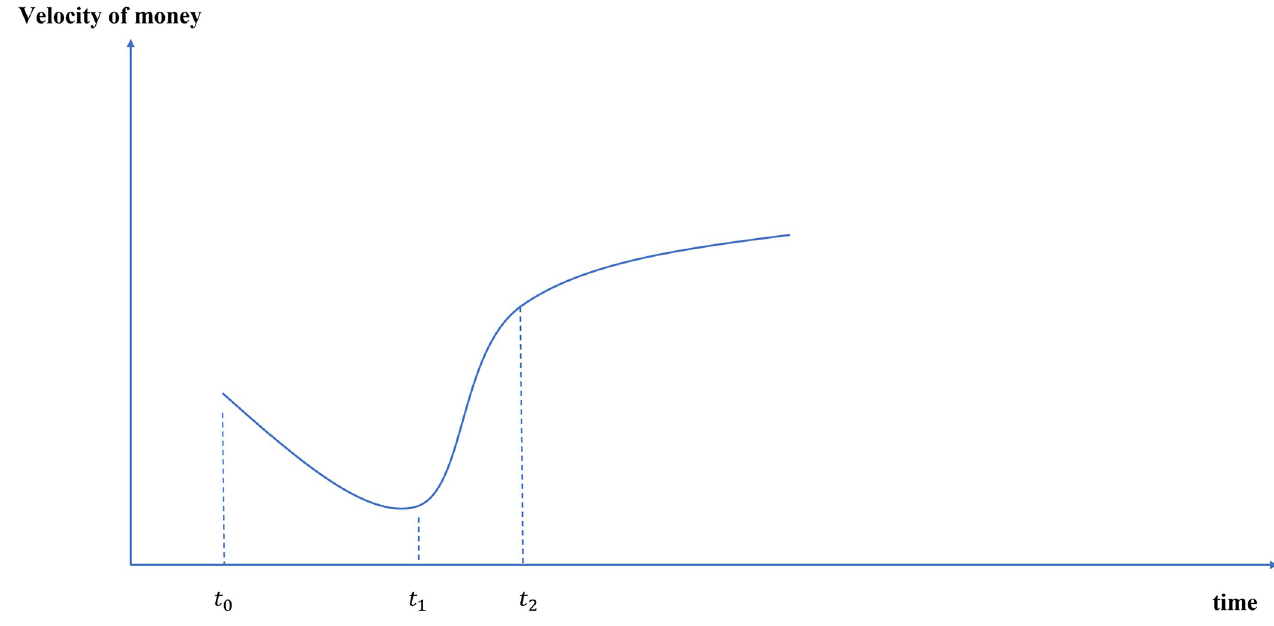
Fig 7. Path changes of currency velocity after e-CNY